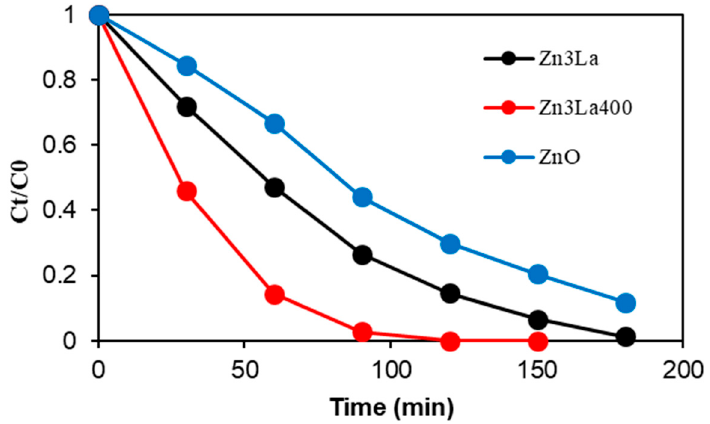
Figure 9. Photocatalytic activity of the prepared samples in clofibric acid (CA) degradation compared to pure ZnO (catalyst load 500 mg/L, CA concentration 20 mg/L, natural solution pH, stirring rate 450 rpm and UV-A irradiation).